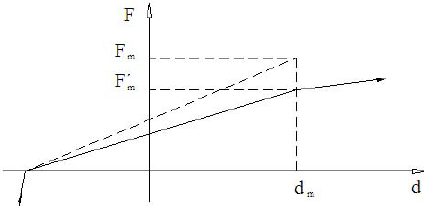
Figure 7. Strength